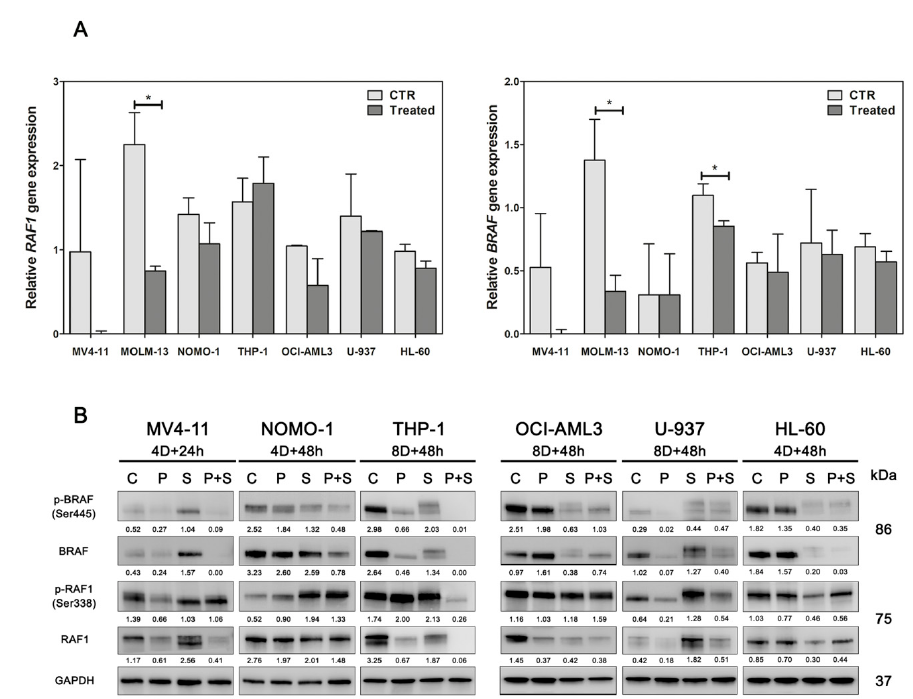
Figure 7. Impact of Pinometostat and Sorafenib on RAF1 and BRAF expression. ( A ) Assessment of BRAF and RAF1 gene expression in AML cell lines treated with the DOT1L inhibitor Pinometostat for 16 days. CTR: control cells (DMSO 0.01%); Treated: cells treated with 1 µ M Pinometostat. Results of three independent replicates are presented. Data are expressed as 2 ∆∆ Ct ± SD, and the universal human reference RNA was used as calibrator. ( B ) Western blot analysis of BRAF and RAF1 total and phosphorylated proteins in AML cell lines treated with 1 µ M of Pinometostat and Sorafenib as single agents or in combination. Combination times are indicated for each cell line (4 / 8D: 4 / 8 days). Antibody to GAPDH served as a loading control. Molecular weights are indicated on right. C: control cells (DMSO 0.01%); P: Pinometostat treatment; S: Sorafenib treatment; P + S: combined treatment (Pinometostat and Sorafenib). Densitometric data were normalized on GAPDH.